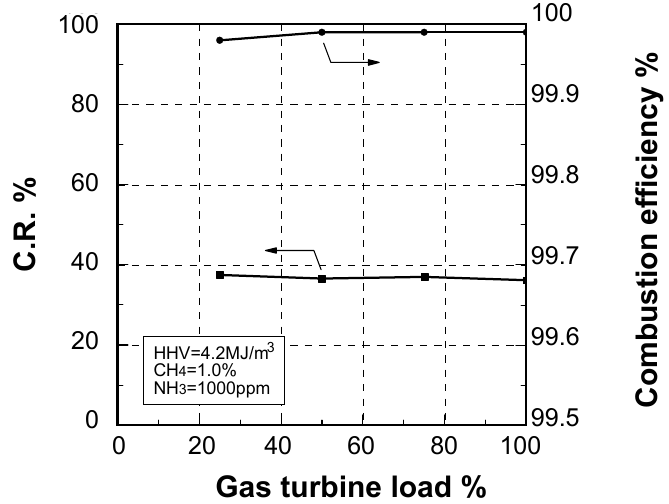
Figure 52. Combustion emission